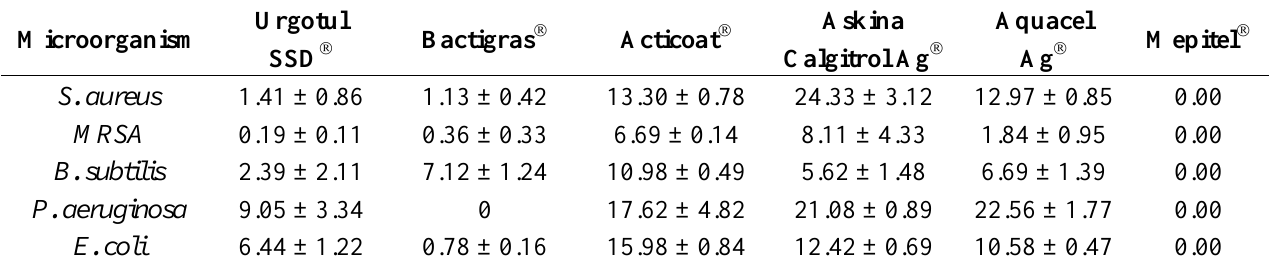
Table 2. Corrected zone of inhibitions (mm) generated by topical antimicrobial